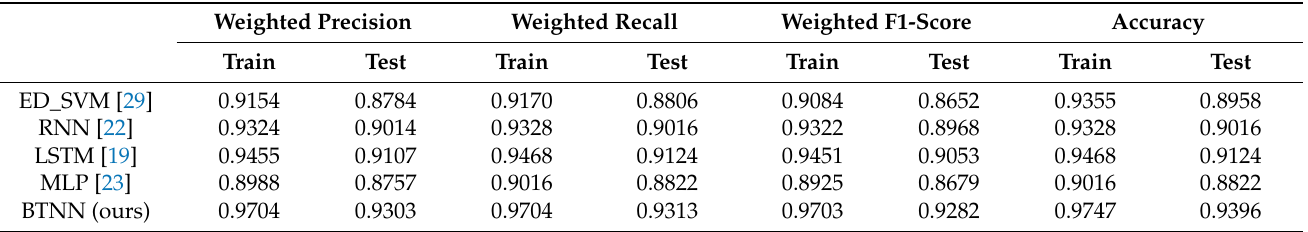
Table 2. The Precision, Recall and F1-score of target identification in training data and test data by different